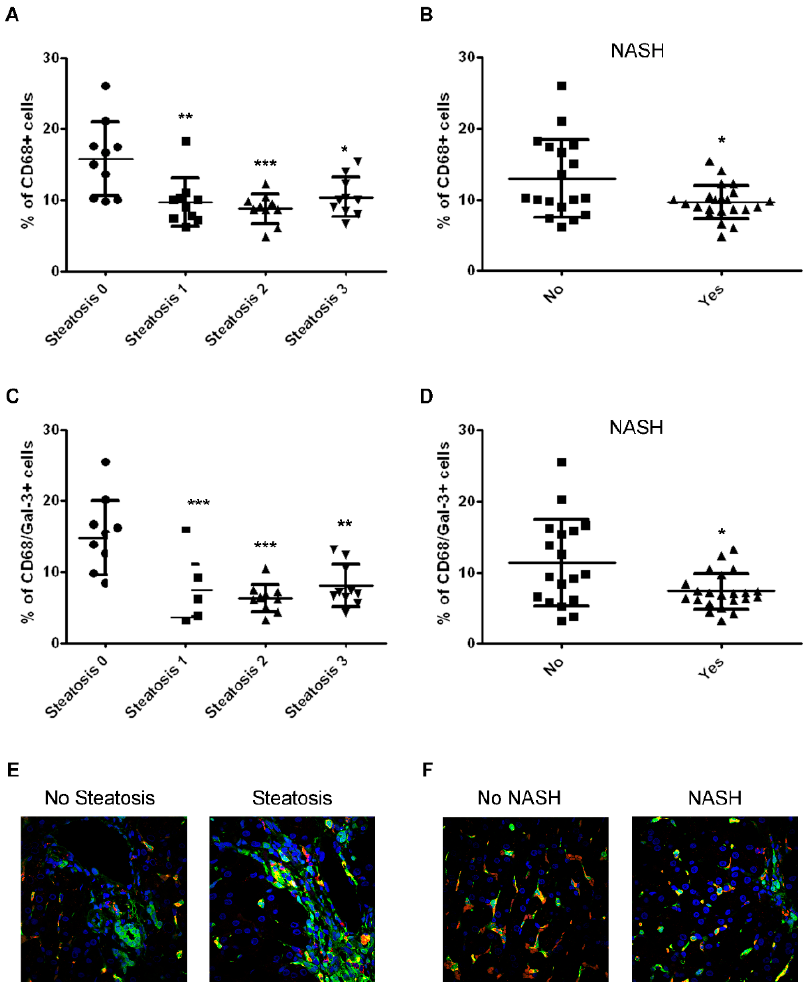
Figure 2. Analysis of the number of hepatic CD68 / Gal-3 positive cells in children with NAFLD associated with the severity of disease. ( A , B ) Percentage of CD68 + cells in the liver tissue from children with NAFLD correlated with degrees of steatosis ( A ) and the presence of NASH ( B ). ( C , D ) Percentage of CD68 / Gal-3 + cells in the liver tissue from children with NAFLD correlated with grades of steatosis ( C ) and the presence of NASH ( D ). *** p < 0.001; ** p < 0.01; * p < 0.05 vs steatosis 0 or no NASH. ( E , F ) Representative image of immunofluorescence of CD68 expression (red) and Gal-3 expression (green) in liver tissues from children with NAFLD showing the presence (steatosis), or not (No steatosis), of steatosis and NASH. Magnification 60 × . Nuclei were counteracted with Hoechst staining (blue). 2.3. The Number of CD68 / CD206 / Gal-3 Positive Cells Decreases with the Severity of Disease in Children